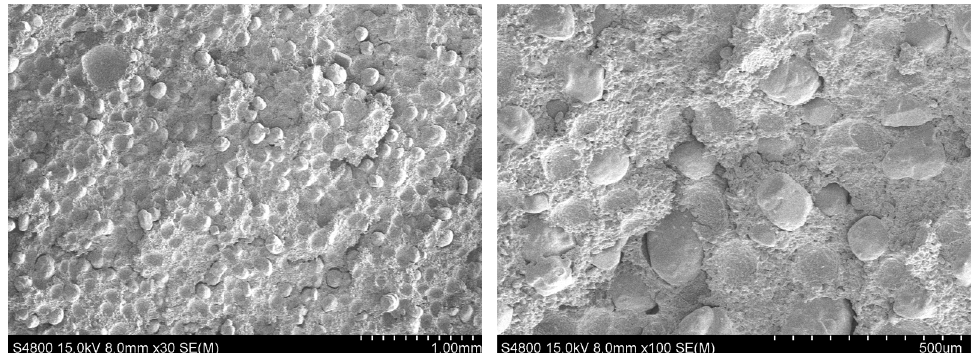
Figure 7. SEM image of initial section of HTPB propellant.